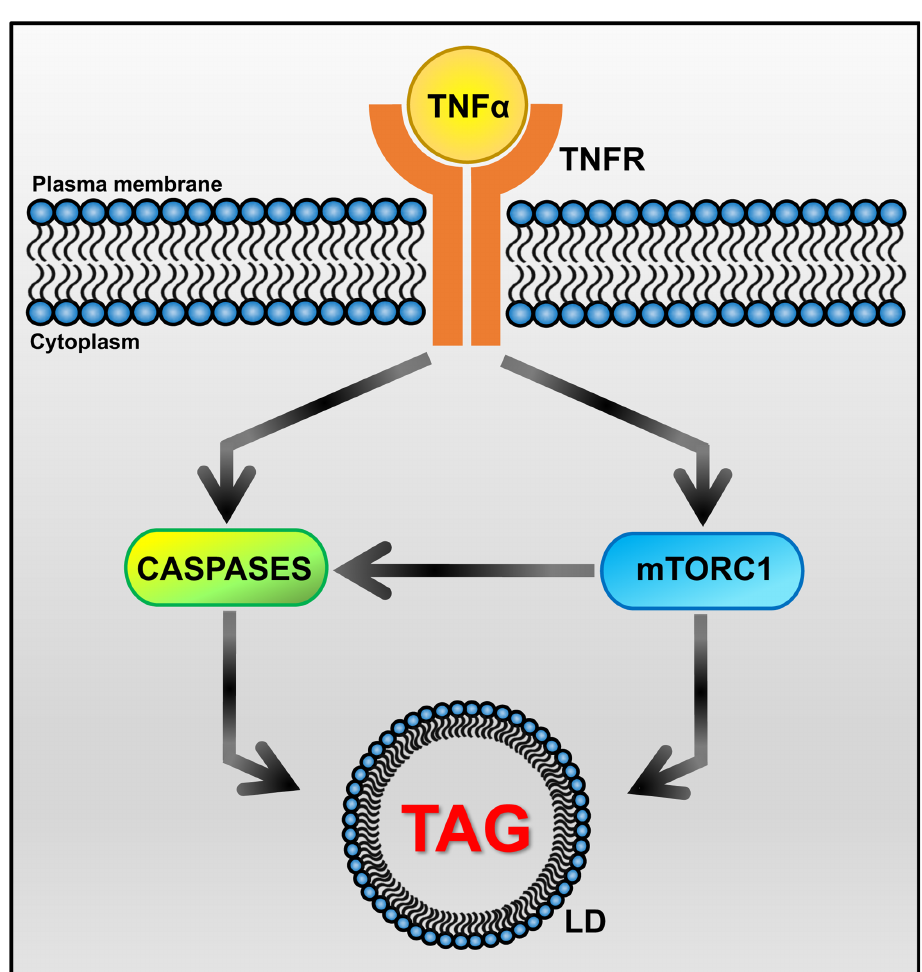
Fig 7. Key nodes of the signaling network involved in TAG accumulation in tuberculous macrophages. Infection of macrophages with M . tuberculosis induces production of TNF α , which has both autocrine and paracrine effects. TNF α binding to its surface receptors (TNFR1 and TNFR2) triggers the activation of intracellular caspase and mTORC1 pathways. Both mTORC1 and caspases directly interact with autophagy effectors to inhibit autophagic flux [42, 52, 109]. So does M . tuberculosis infection [110]. In addition, mTORC1-dependent block of autophagy can also activate the caspase cascade through accumulation of p62, which binds and activates caspase 8 [111]. When autophagy is blocked, lipid droplets are not degraded and accumulate in the cytoplasm. Our observation that treatment with TNFR neutralizing antibodies relieves the inhibition of autophagy by M . tuberculosis infection (S6 Fig) further supports inhibition of autophagy as a driver of lipid droplet accumulation in tuberculous macrophages. In addition, caspase activation also leads to mitochondrial dysfunction [43], which results in accumulation of lipid droplets due to reduced fatty acid utilization [39]. Effects on TAG biosynthesis may also be involved, since mTORC1 induces expression of SREBF1 [112–114] and caspases activate SREBPs [40, 41]. Arrowhead: positive regulation. LD: lipid